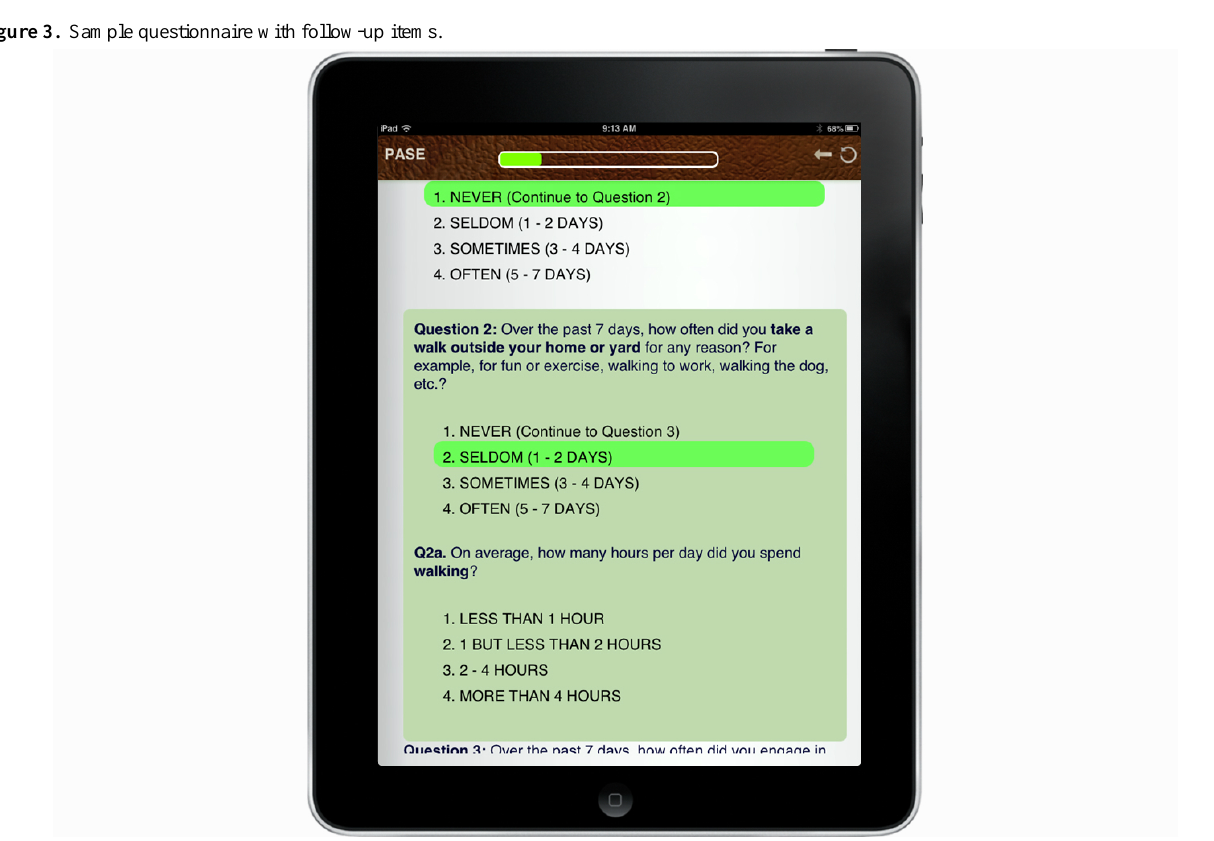
Figure 3. Sample questionnaire with follow-up